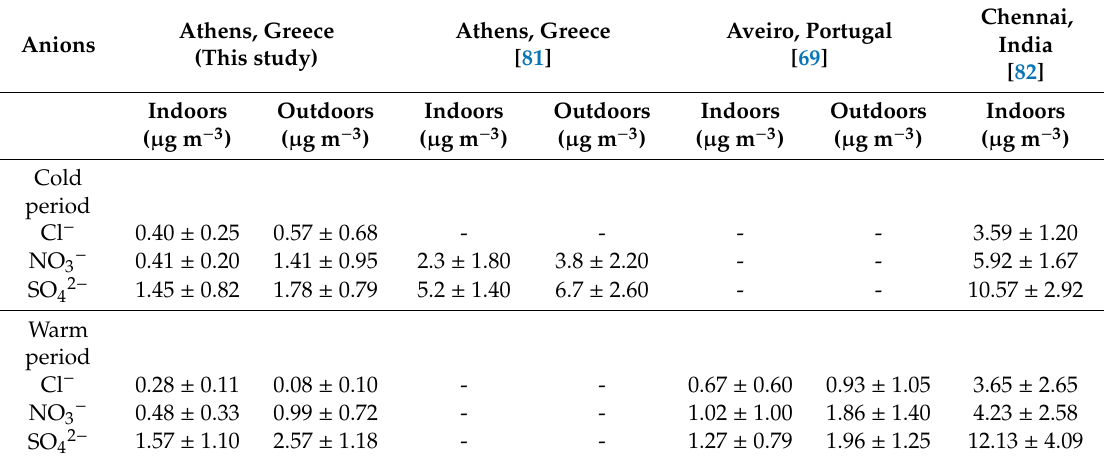
Table 5. Average values of PM 10 anionic components in di ff erent sampling